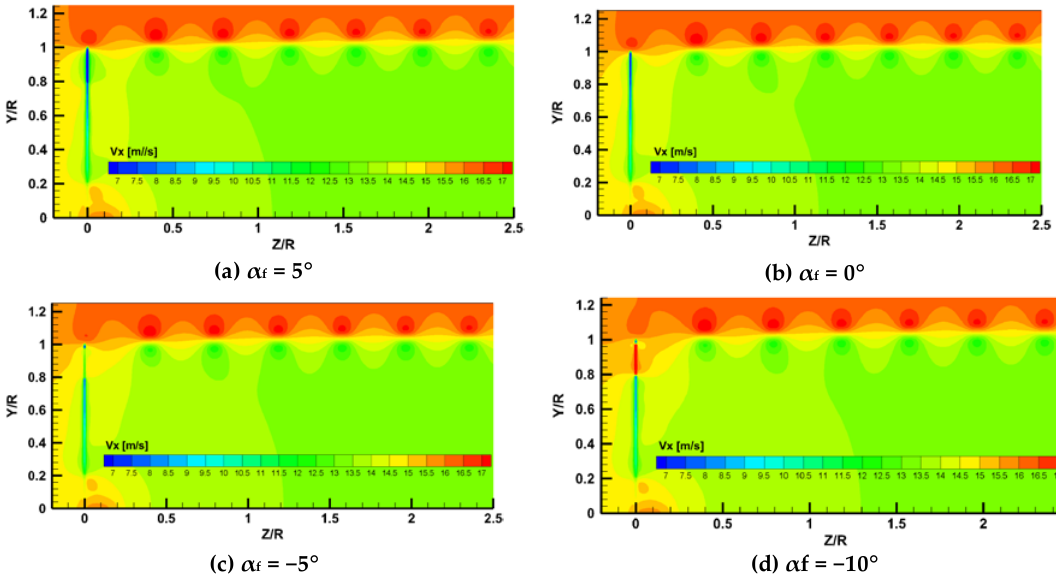
Figure 9. Axial velocity distribution on the plane with a 0° wake angle for U = 11.4 m/s. (Position: Axial direction from − 0.2 R to 3 R , radial direction from 0 to 1.25 R ). ( a ) α f = 5°, ( b) α f = 0°, ( c ) α f = −5 °, ( d ) α f = −10 °.